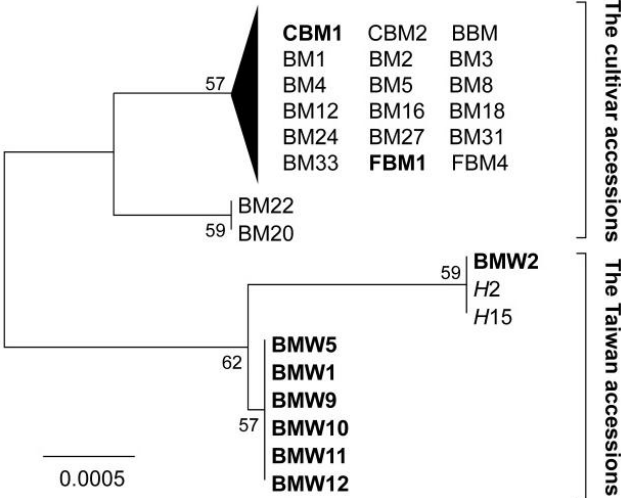
Figure 1. The neighbor-joining tree of the cultivars and wild samples of Taiwan, India, and Korea of Momordica charantia, inferred by the chloroplast atp B- rbc L spacer. Samples denoted in regular, bold, and italic are the cultivars, wild samples, and hybrids, respectively. The CBM1 and the FBM1 are wild samples from India and Korea, respectively. Each wild population and landrace cultivar variety included five to eight individuals with the same haplotype in the figure. Numbers between the branches are the supporting values for monophyly by 1000 bootstrap replications.